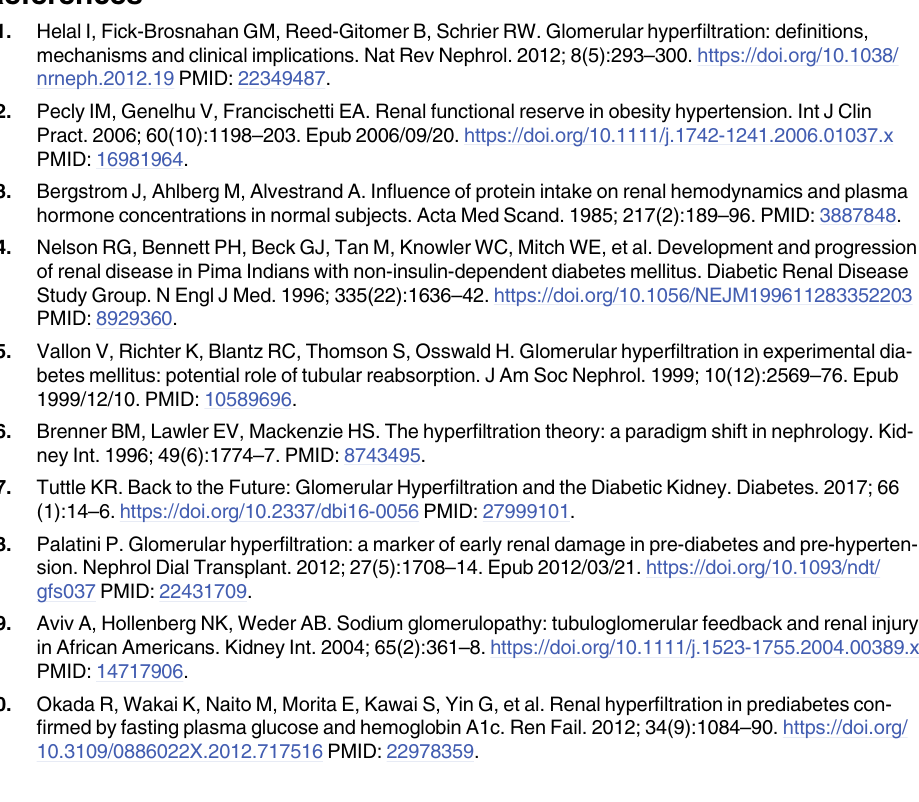
S2 Table. The estimated glomerular filtration rates (ml/min/1.73 m 2 ) of healthy subjects stratified by age and sex. S3 Table. Multiple logistic regression analyses of odds ratios for hyperfiltration, stratified by fasting plasma glucose and serum triglyceride